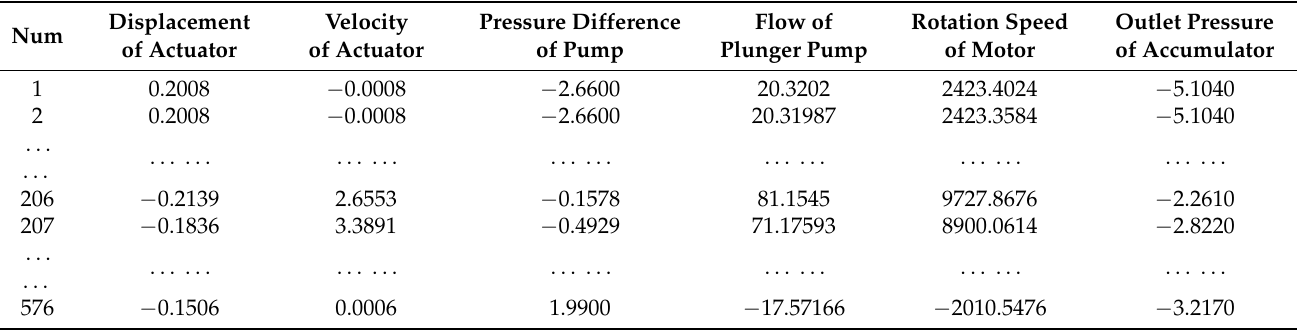
Table 2. Data of a fault sample